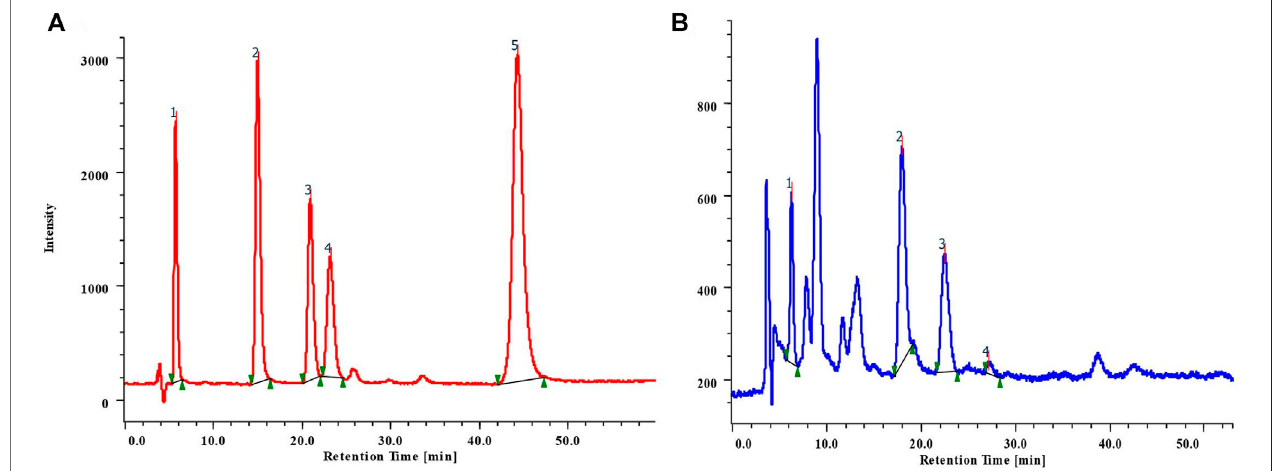
TABLE 3 | HPLC analysis of phenolics from the leaves and stem extracts of B. terminalis and C. grandi fl orus . Plant